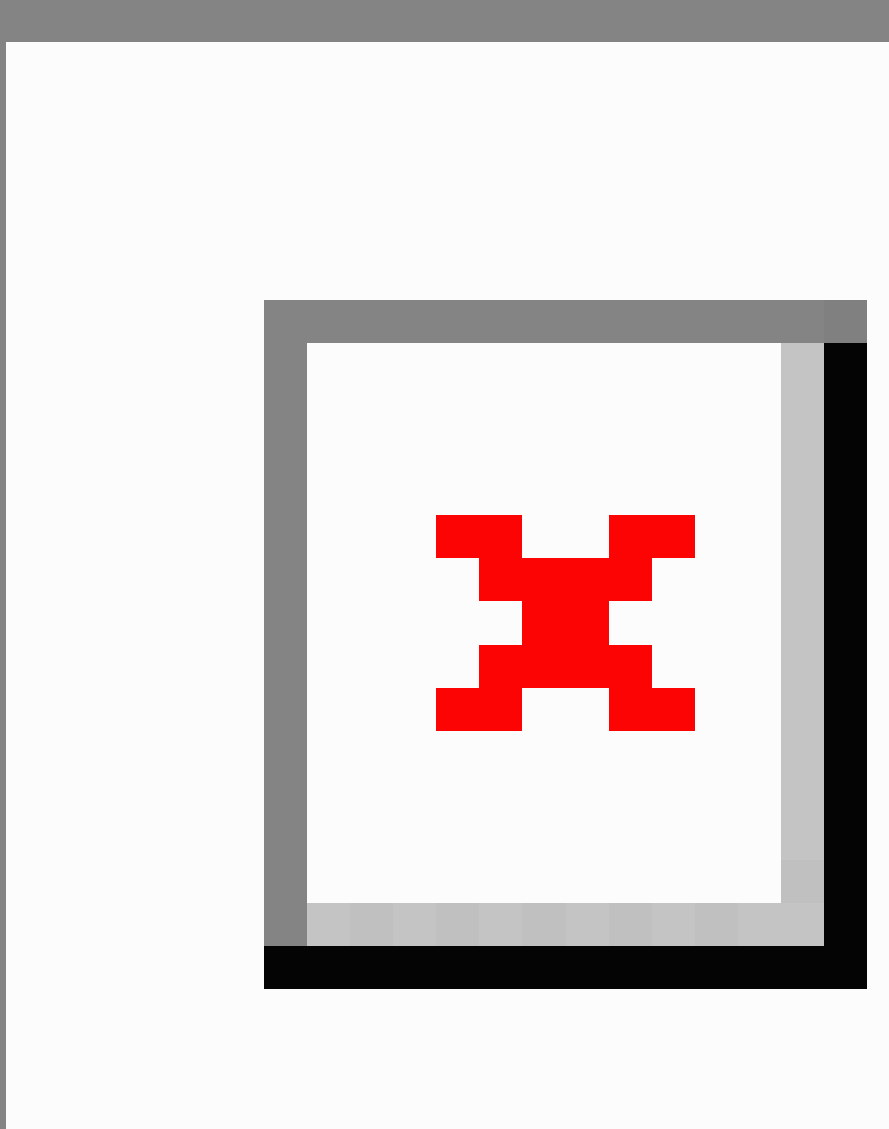
Figure 2. Screenshots of the virtual clinic: discussion